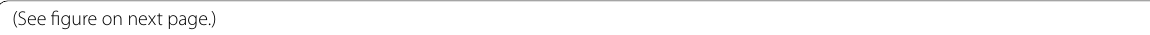
Fig. 1 Screening of GSK3β inhibitors. a High‑content screen of SARS‑CoV‑2 (full circles) and HCoV‑229E (empty circles) infected Huh‑7.5.1 cells with the Takeda GSK3β‑focused library at a single dose of 10 μM. Inhibition was interpolated to both a non‑infected control and an infected, untreated control, quantifying intracellular dsRNA. Cell loss was assessed to avoid quantifying small populations and compounds resulting in > 25% cell loss are marked in red. Compounds marked with an asterisk were further pursued. The Z’ of two independent screens were 0.54 and 0.74 for SARS‑CoV‑2 and 0.68 for HCoV‑229E. b‑c Dose‑response validation of compounds of interest. Each dose is an average of four independent experiments, error bars show SEM. Viral load of SARS‑CoV‑2 ( b ) was determined by measuring intracellular N protein and viral load of HCoV‑229E ( c ) by measuring dsRNA. d Western analysis of SARS‑CoV‑2 N protein, representative blot of four